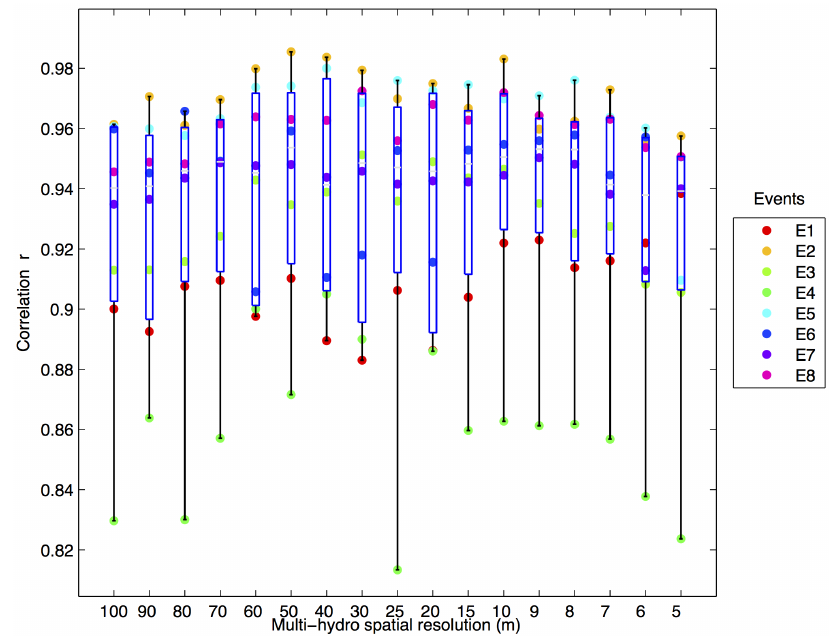
Figure 15. Results of model hydrodynamic evaluation; the correlation coefficient r was retrieved for each modelling output with respect to real